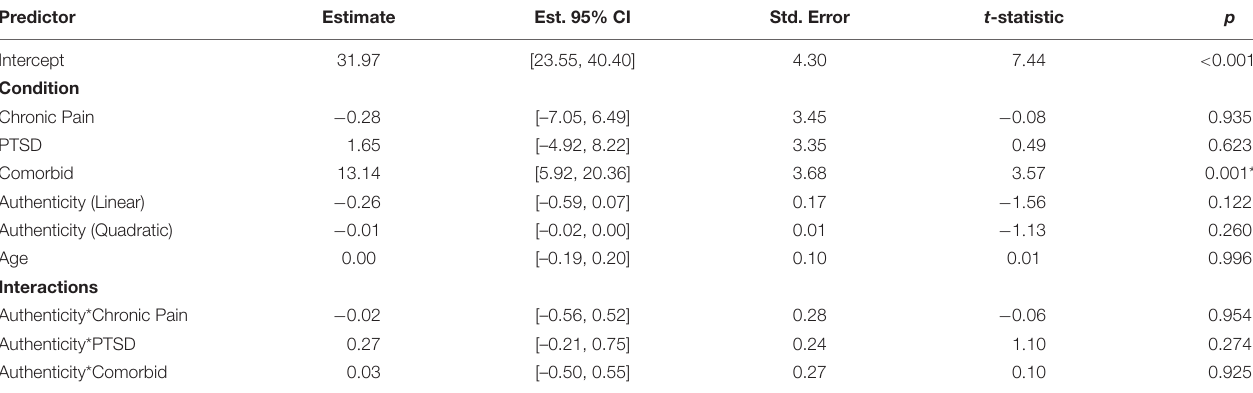
TABLE 4 | Regression estimates – CV-19 Impact.